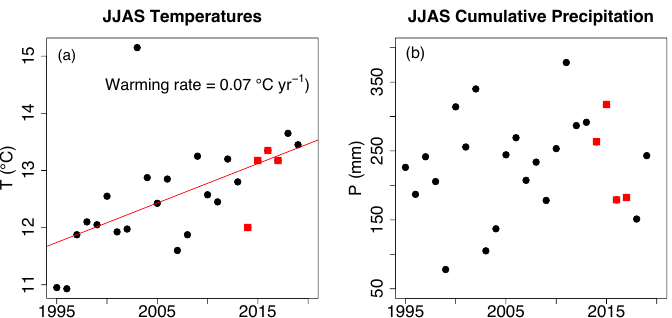
Figure 5. June-to-September (JJAS) period 1995–2019 (data from ARPA-VdA station). ( a ) Average air temperature. ( b ) Cumulative precipitation. Red squares represent the 2014–2017 data mean air temperature and precipitation. Black circles represent the same variables but in the other